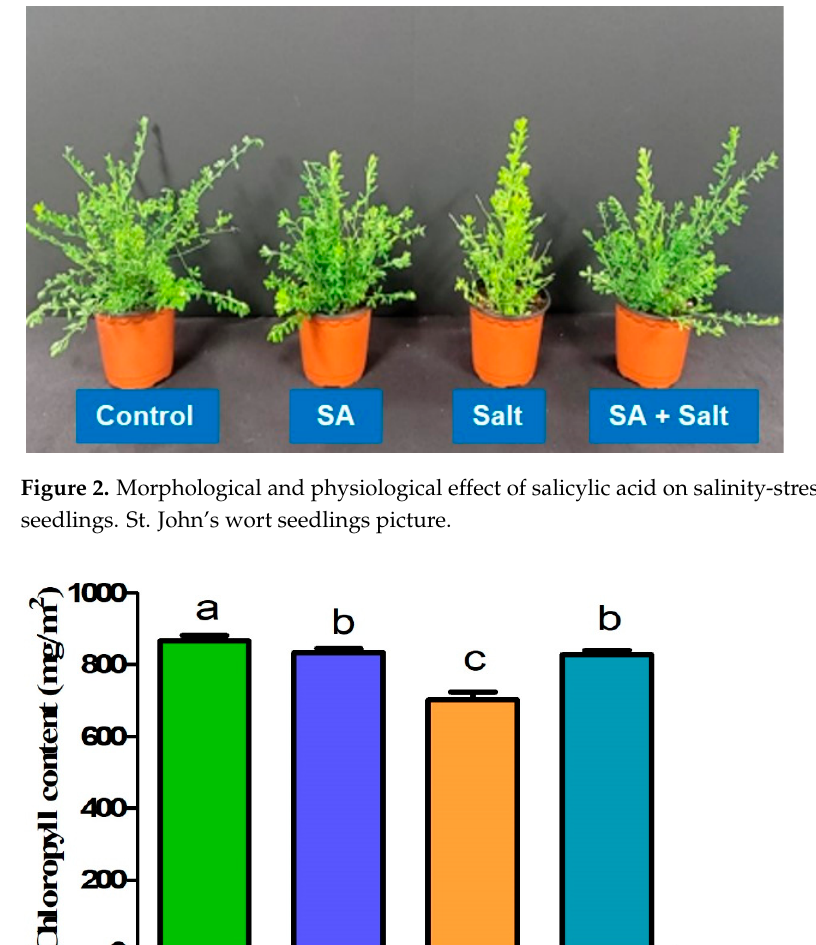
Table 1. Growth parameters of salicylic acid on salinity ‐ stressed St. John’s wort seedlings. St. John’s wort seedlings picture.